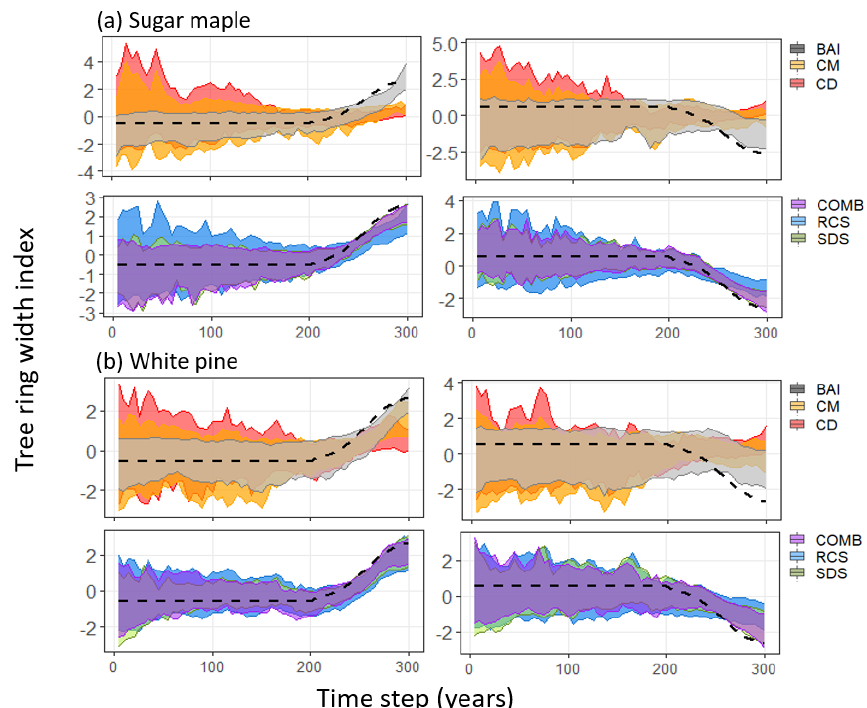
Figure 2. The 95% confidence intervals for standardized chronologies produced by each standardization method (legend on the right side) applied to SORTIE-simulated (a) sugar maple and (b) white pine tree ring data. Confidence intervals obtained via bootstrap resampling (rep = 100) of 60 trees ( > 10cm DBH) from the SORTIE-simulated populations. Dotted lines indicate the standardized positive (left side) or negative (right side) logistic trend that was added to the raw tree ring